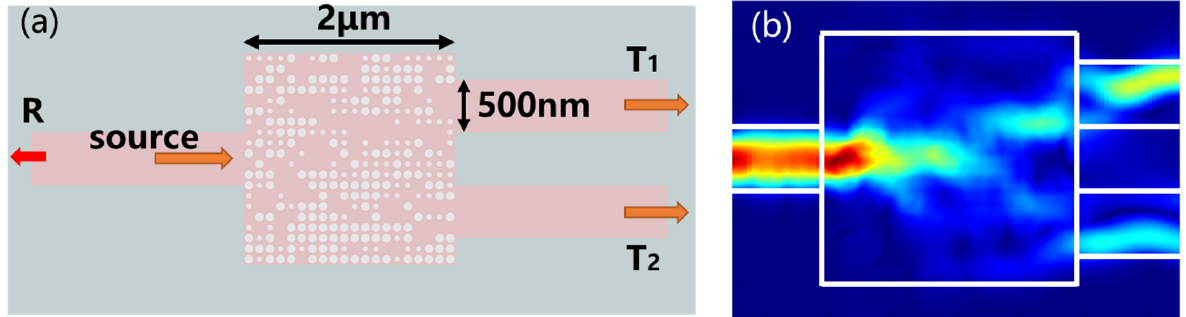
Figure 1. ( a ) The schematic structure of the MMI power splitter, and ( b ) the power distribution in the interference region of MMI at 1550 nm wavelength.